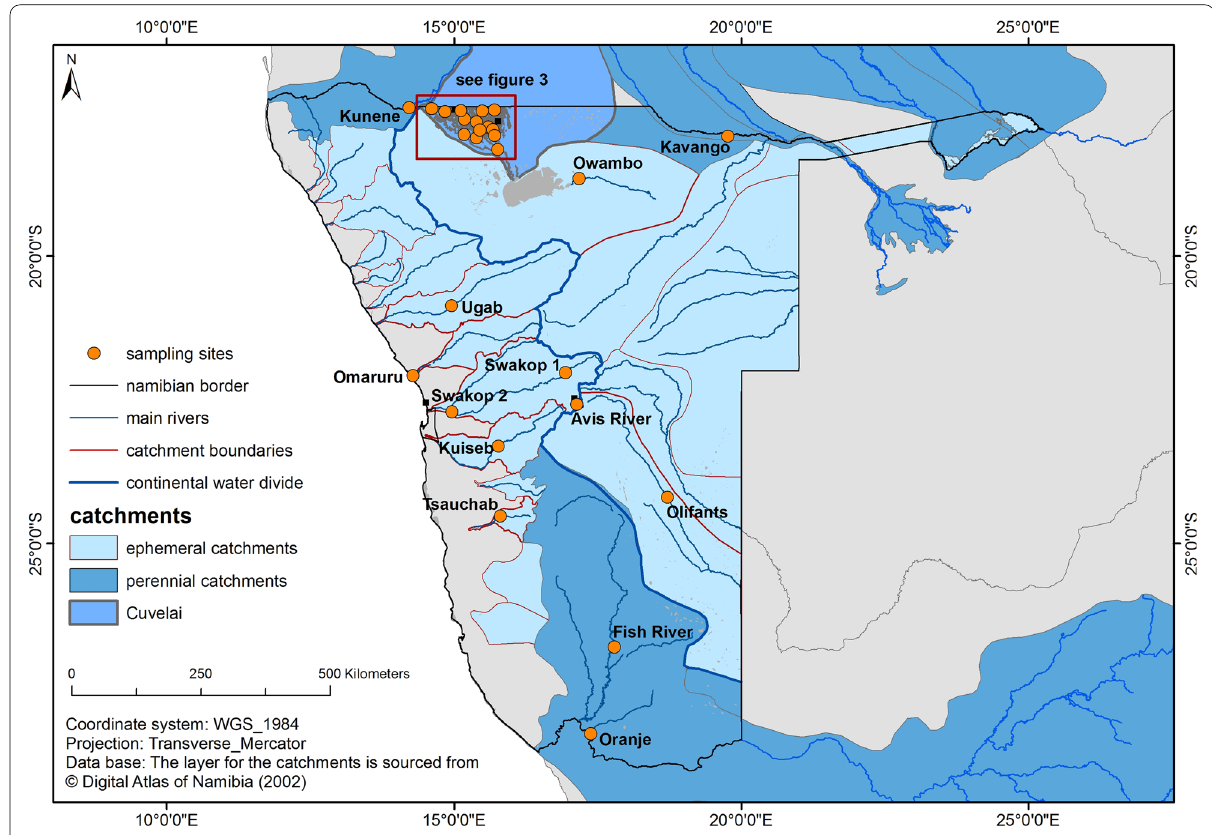
Fig. 2 Locations of the sampling sites in Namibia, with the focus region in central northern